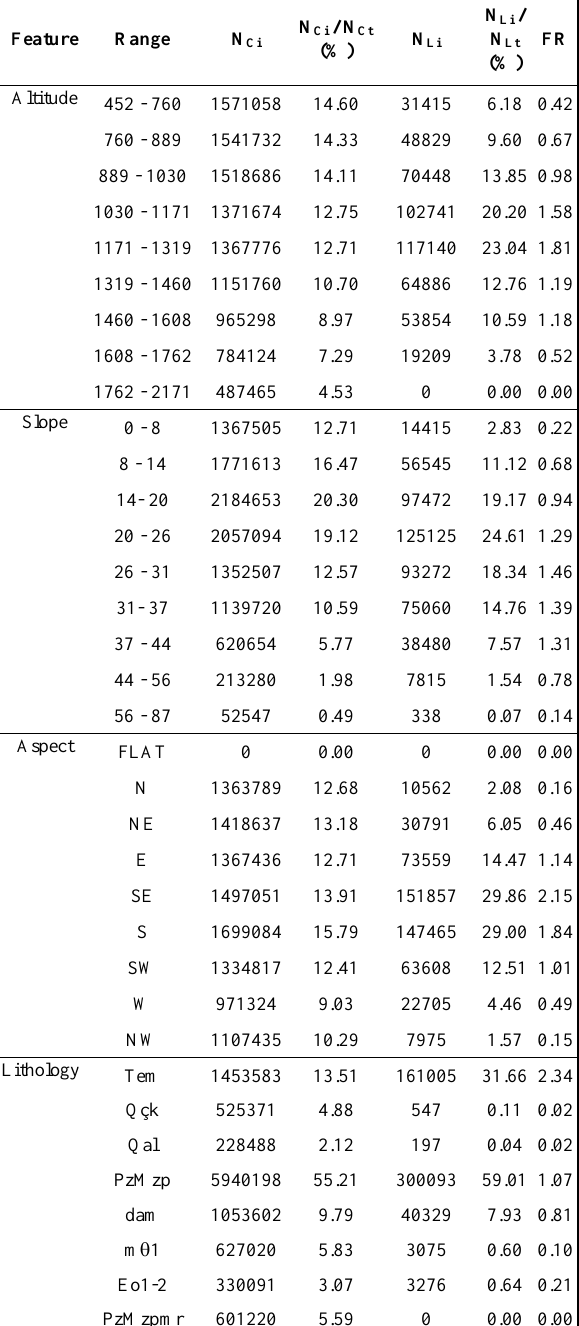
Table A1 . FR statistics Malatya part (altitude, slope, aspect,